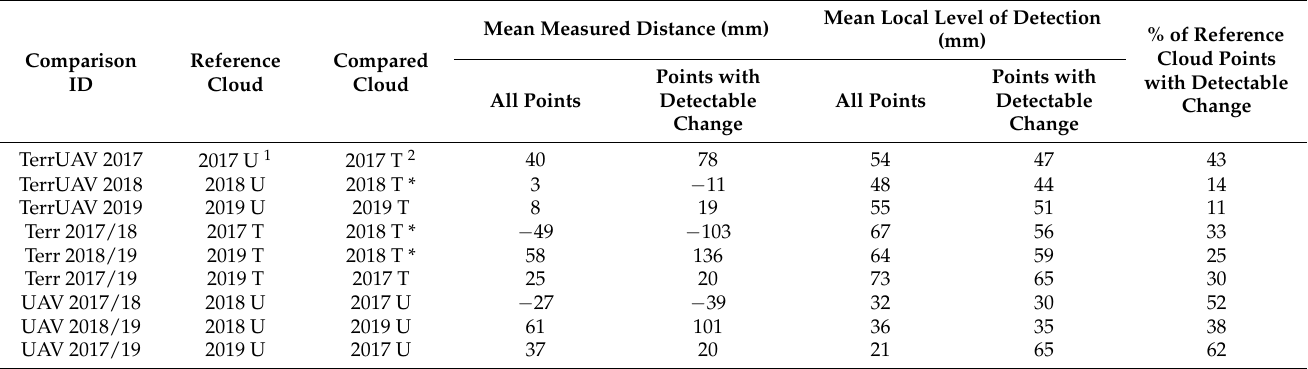
Table 4. Results of the M3C2 comparisons made between the terrestrial and aerial point clouds to analyze the difference between using a different sensor and between the years to analyze the changes within the